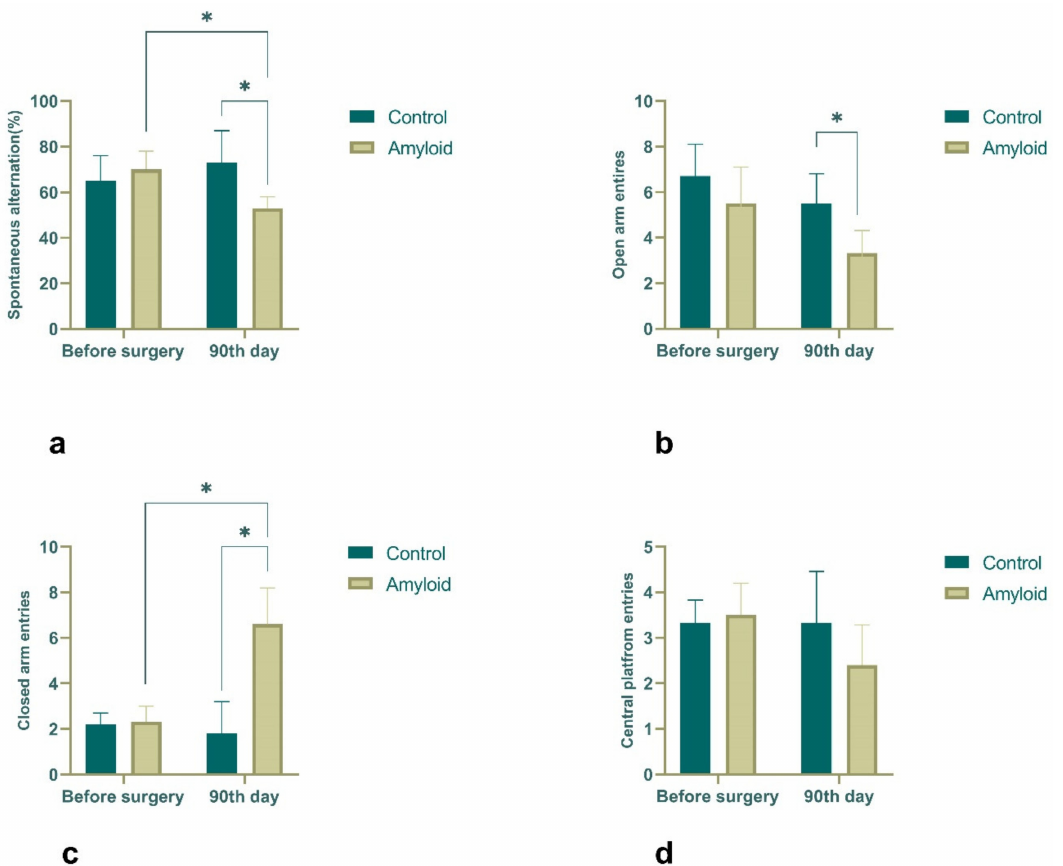
Figure 6. Y-maze ( a ) and elevated plus maze ( b – d ) test results: spontaneous alternation in the control and experimental groups before and after 90 days of amyloid exposure ( a ); counts of open arm entries ( b ), closed arm entries ( c ), and central platform crossings ( d ) before and after 90 days of amyloid single exposure. Statistical significance is indicated as follows: * p <